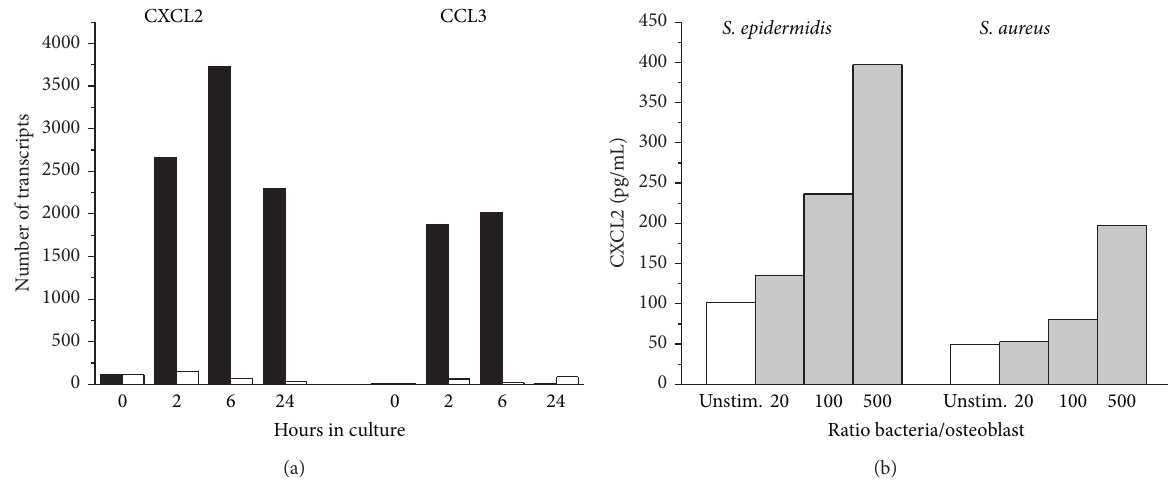
Figure 3: CXCL2 and CCL3 synthesis by cultivated osteoblast. (a) Gene expression of CXCL2 and CCL3 following stimulation of osteoblasts with LTA (1 𝜇 g/mL) for the time indicated. (b) Release of CXCL2 into the supernatant determined following stimulation of osteoblasts with either S. epidermidis or S. aureus in three doses (given as ratio of bacteria per osteoblasts) (one of three independent experiments giving essentially similar results is